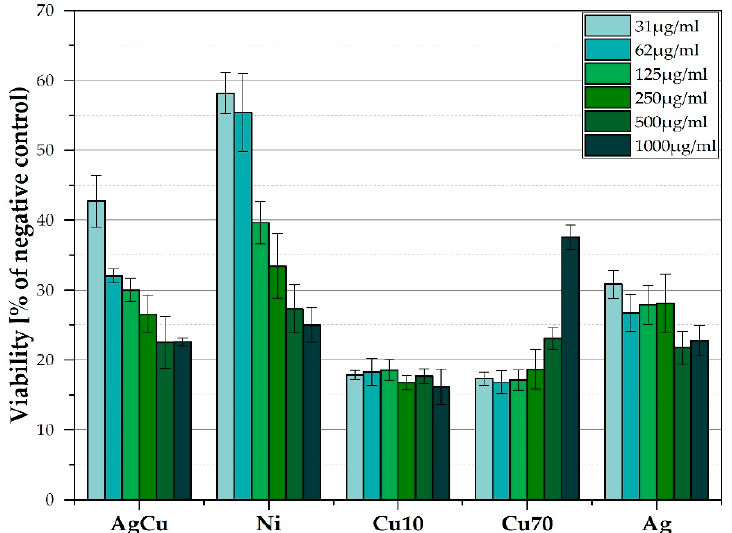
Figure 6. Results of the Saos-2 viability for the examined nanoparticles of silver (Ag), nickel (Ni), silver-copper (AgCu), copper with particles size in a range of 10–30 nm (Cu10), and copper with particles size in a range of 70–100 nm (Cu70).